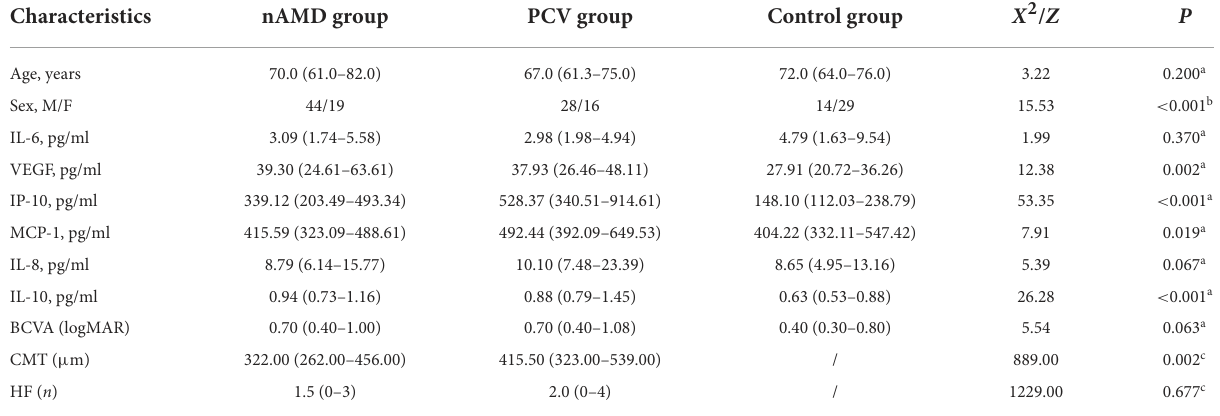
TABLE 1 Baseline characteristics among three groups.